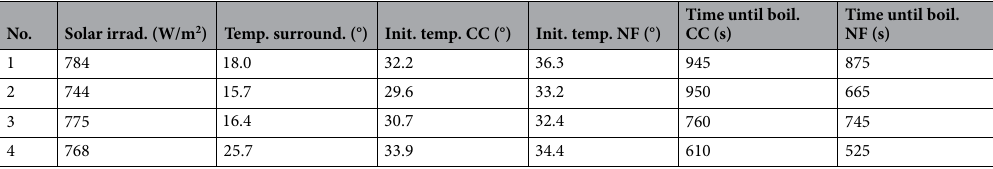
Table 1. Outdoor